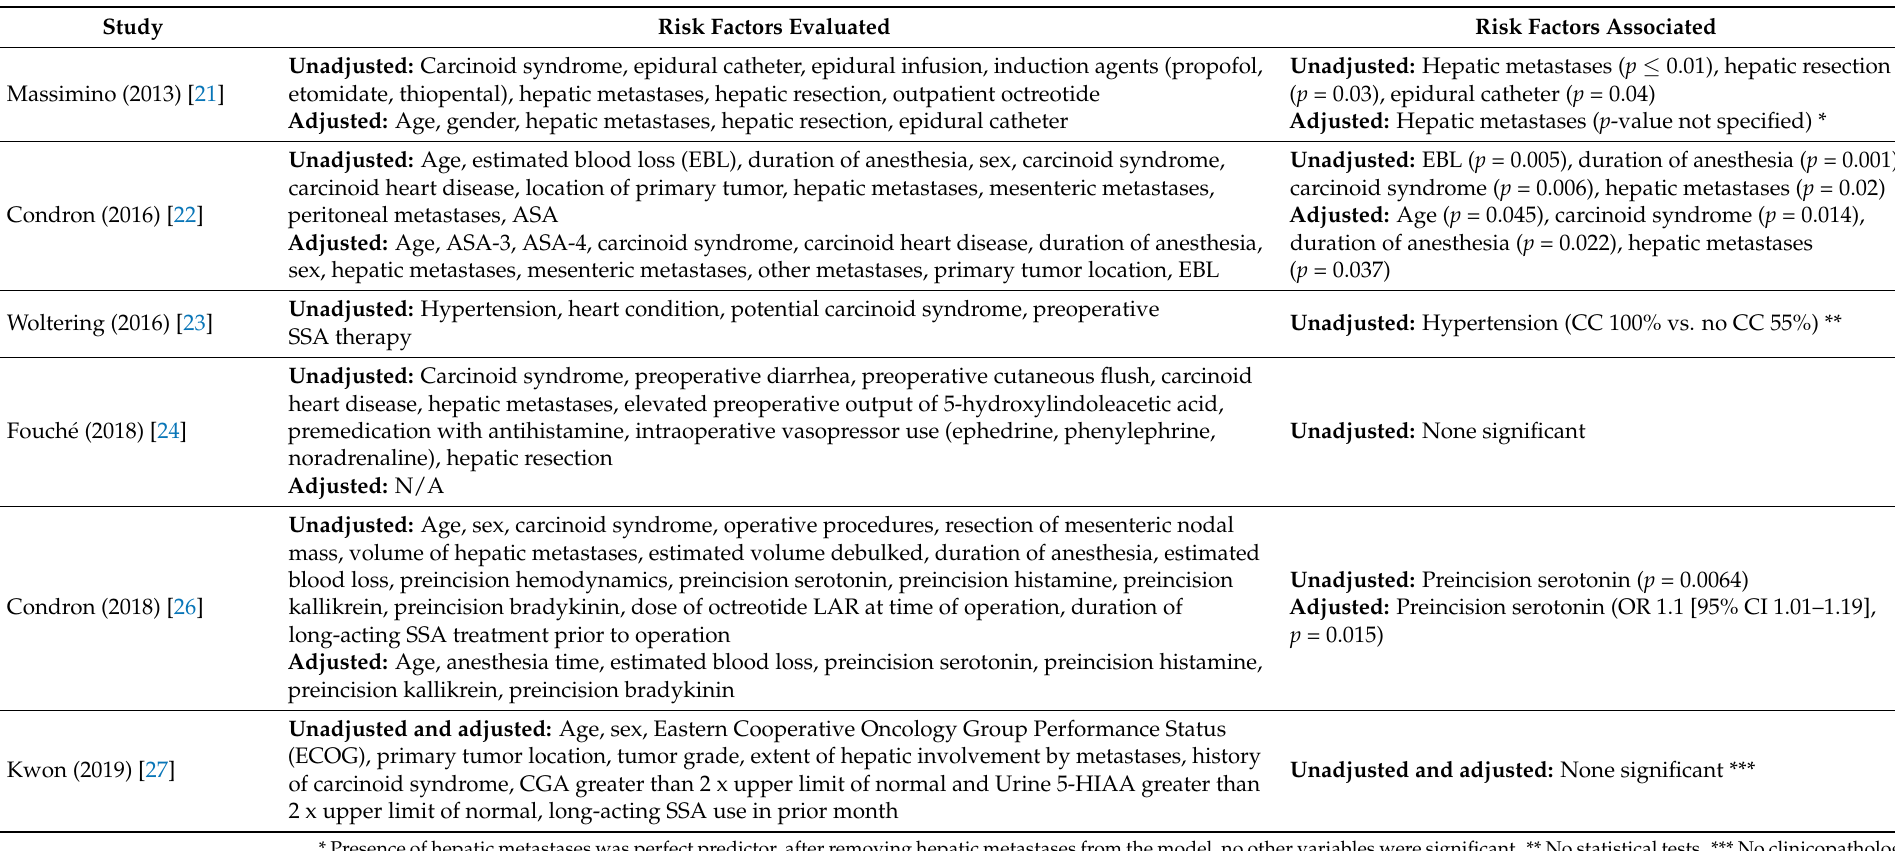
Table 2. Risk factors of carcinoid